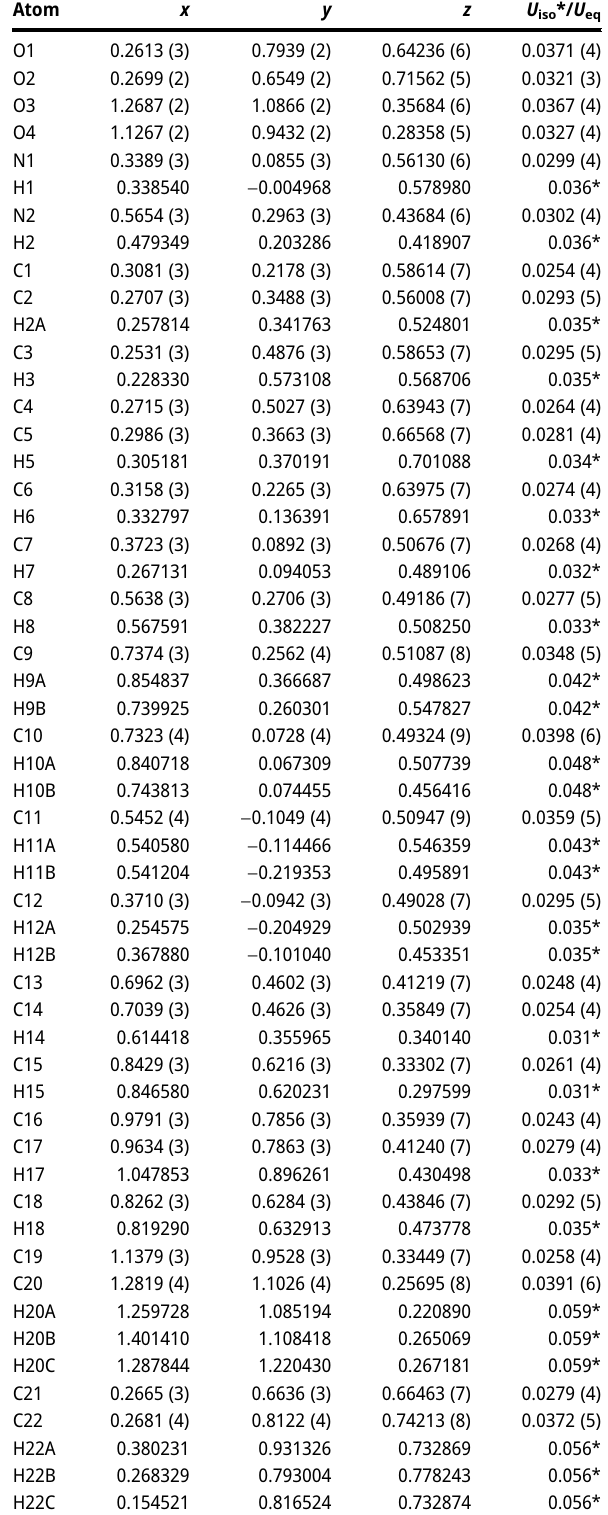
Table  : Fractional atomic coordinates and isotropic or equivalent isotropic displacement parameters (Å 